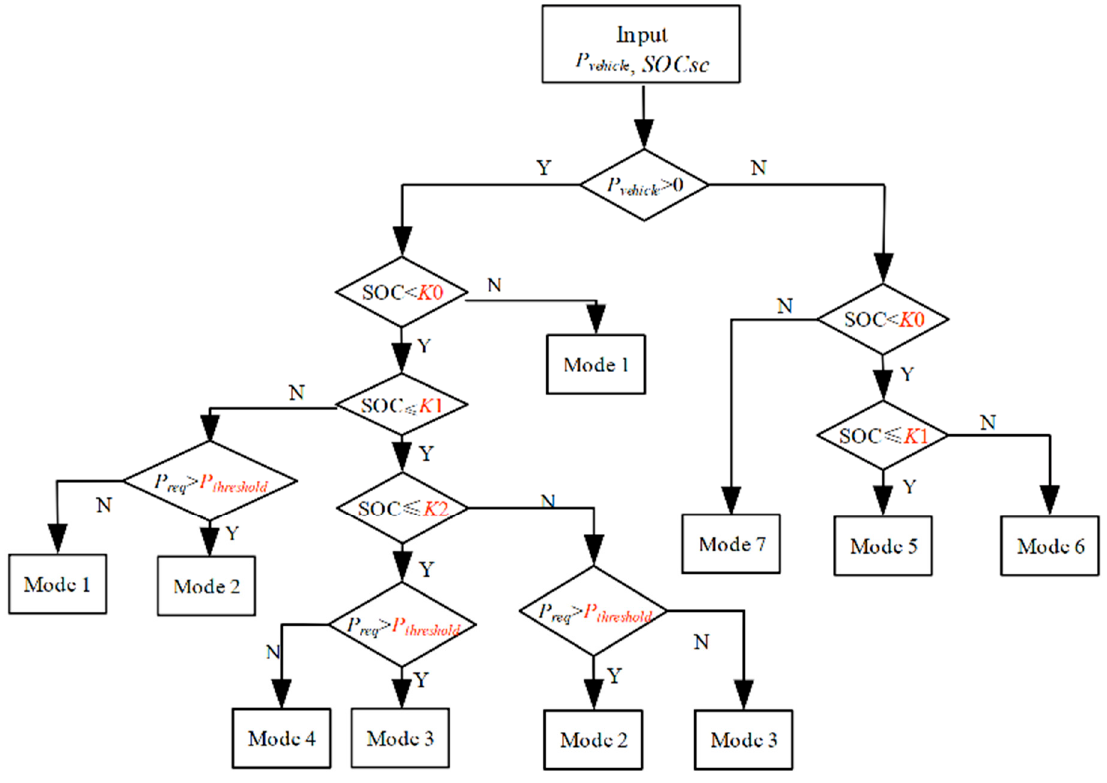
Figure 12. Rule-based algorithm.